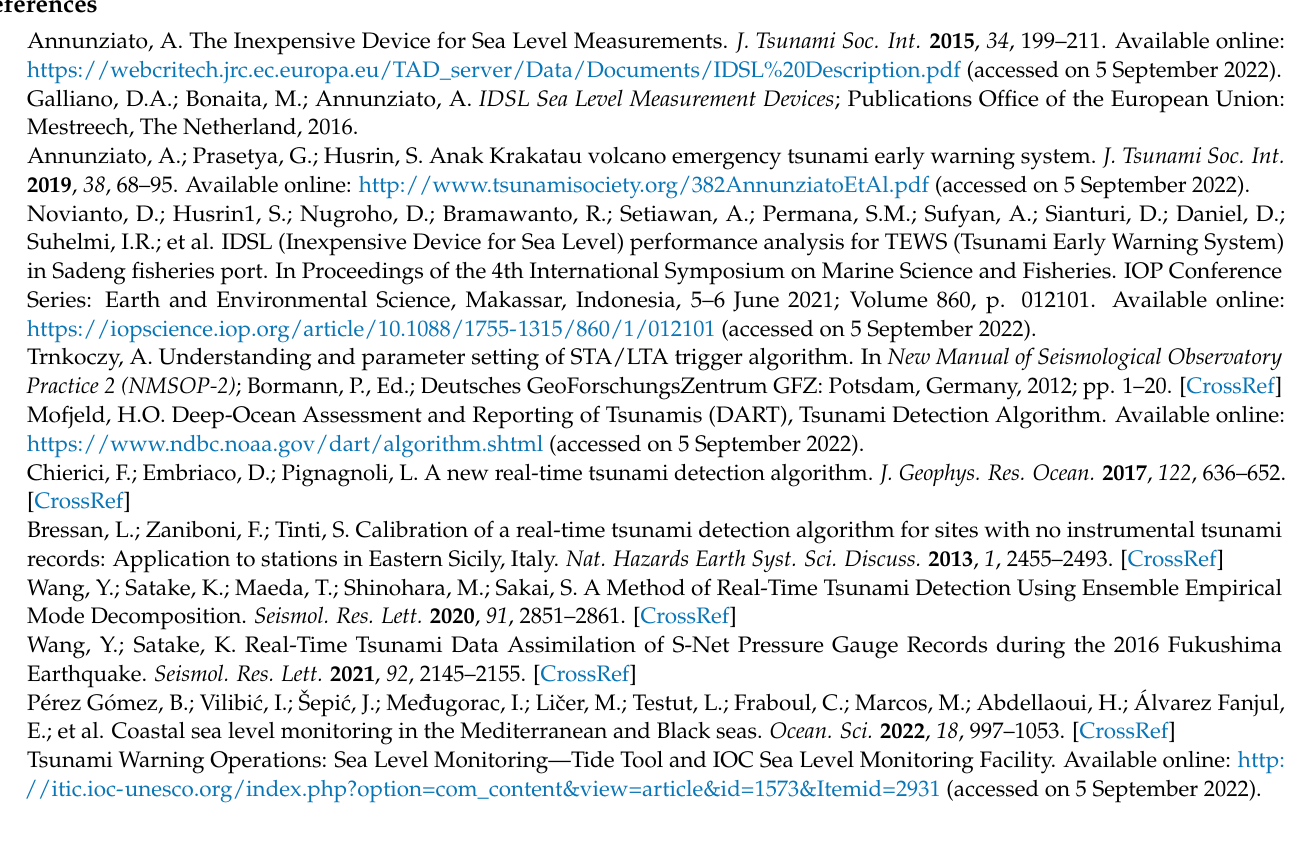
Figure A4. Screenshot of the section to change the parameters of the model.